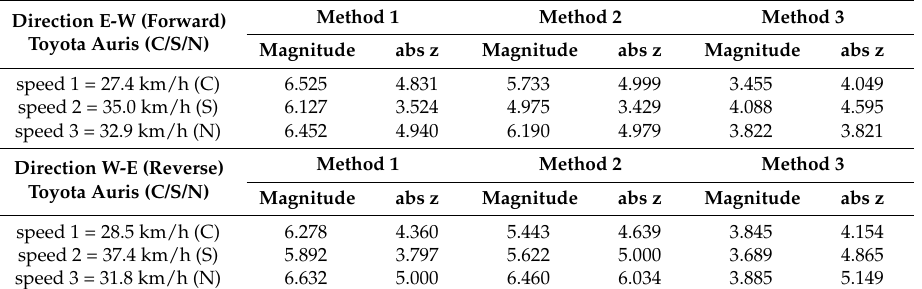
Table 2. Signature length and two-extreme-peak distances (in meters) computed by means of three